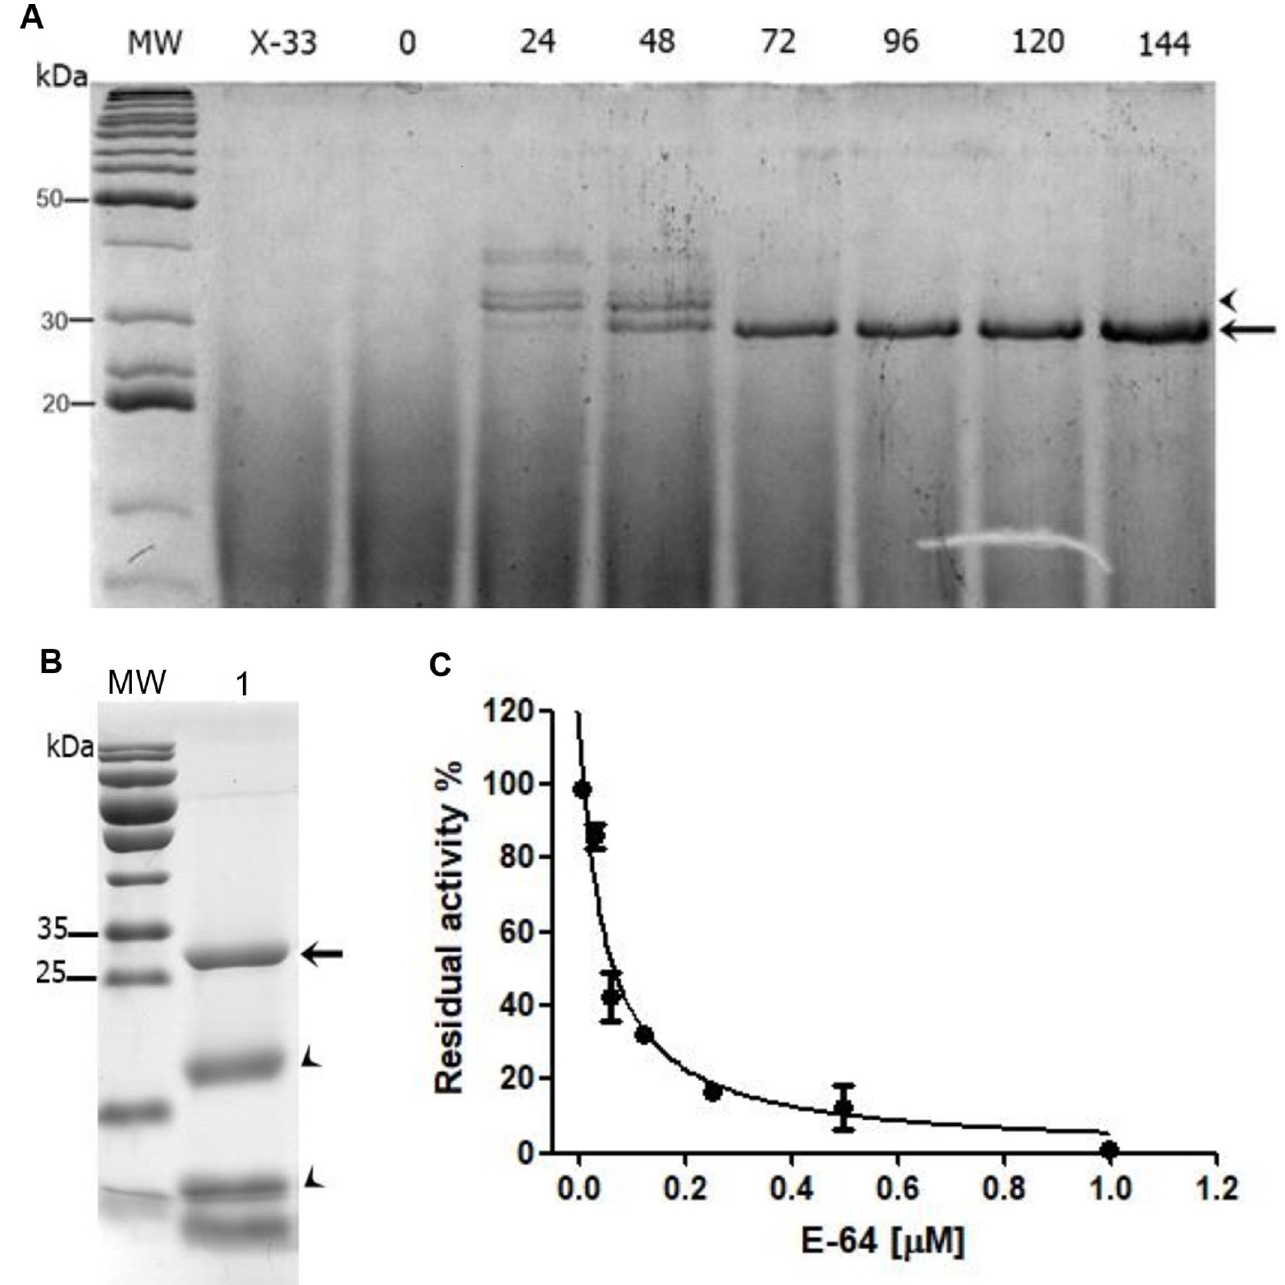
Fig 2. Analysis of CPB expression in P . pastoris . (A) SDS-PAGE showing the supernatants of non- transformed Pichia pastoris X-33, and aliquots from 0 to 144 hours of the transformed clone pPIC-CPB2.8#25 induced with methanol. The arrow indicates the expected size for active (processed) CPB. The arrowhead indicates the unprocessed protein after 24 and 48 h induction. MW: molecular weight Bench Mark (Invitrogen). (B) Analysis of L . mexicana CPB after purification and dialysis. Coomassie-stained SDS-PAGE 15% showing in MW: molecular weight Page Ruler (Thermo Scientific); 1, the purified and dialyzed recombinant CPB. The arrow indicates the recombinant protein (about 26 kDa) and the arrowheads, the products of proteolysis. (C) Active site titration of the recombinant CPB using the irreversible protease inhibitor E-64. Residual activity % (Relative Fluorescence Units) was measured by the ratio between the enzyme activity in absence or presence of increasing concentrations of